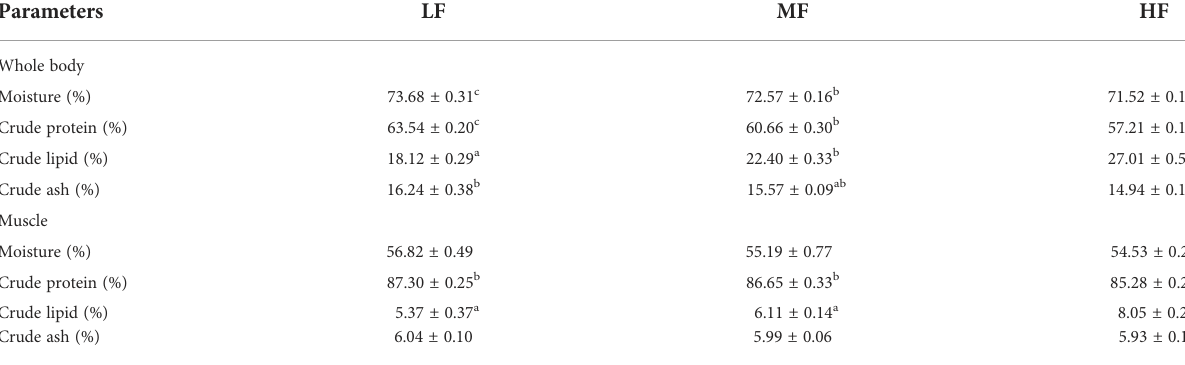
TABLE 5 Effect of dietary lipid levels on whole body and muscle composition of hybrid grouper (% dry matter). Parameters